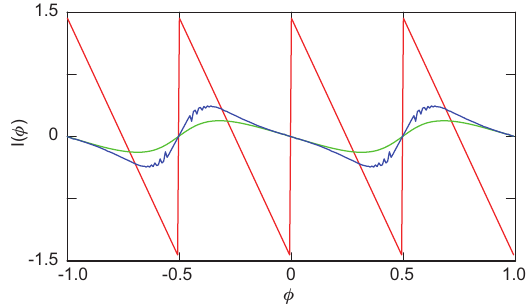
Figure 14 Persistent current as a function of fl ux φ for a half-fi lled mesoscopic cylinder considering N = 15.